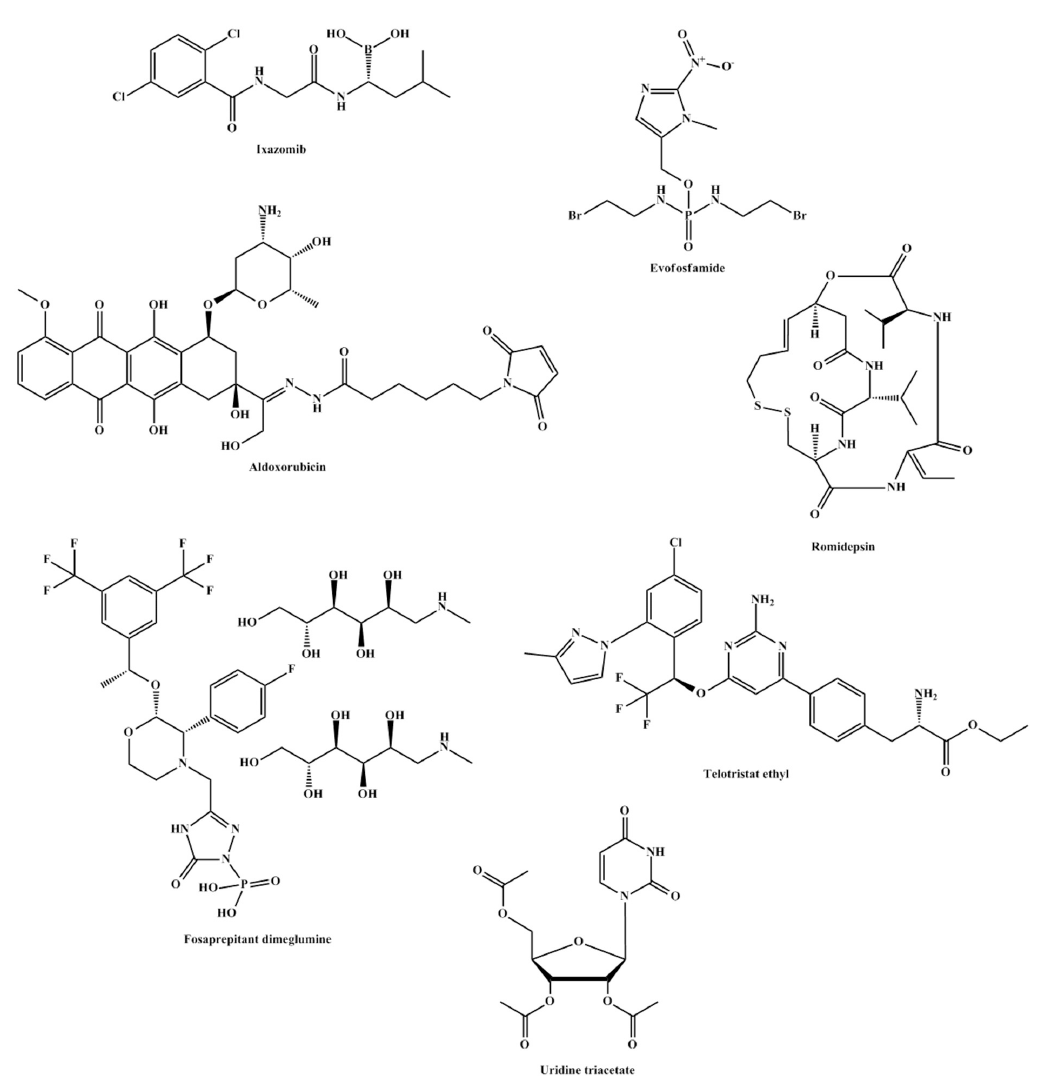
Figure 3. Structures of prodrugs reported in this sub-section.